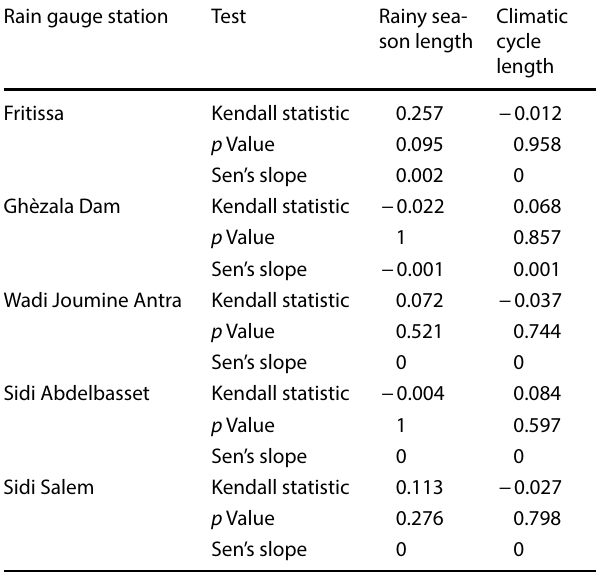
Table 16 Trends in the rainy season and climatic cycle length